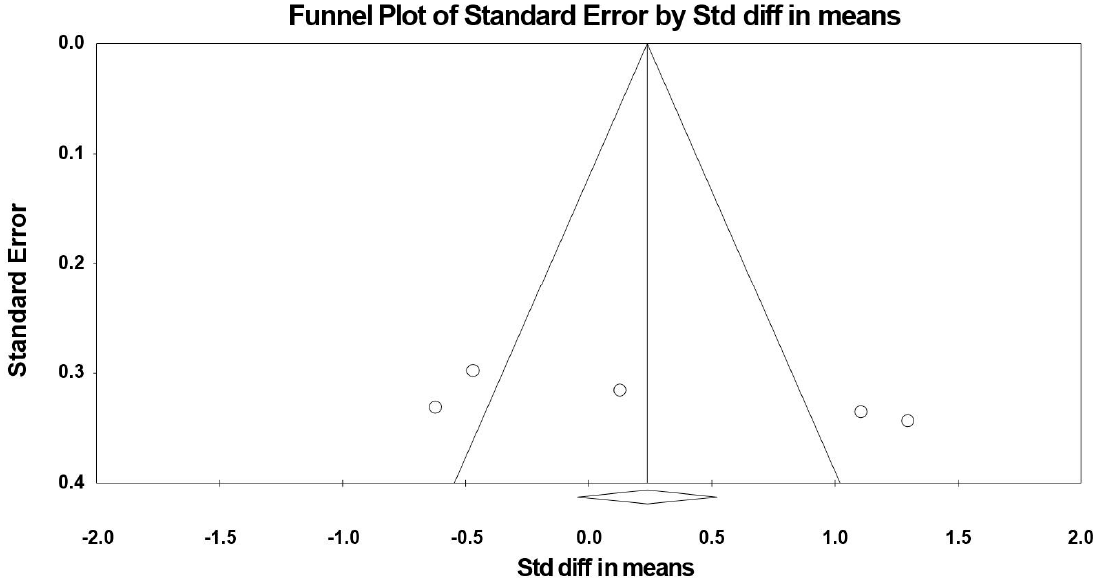
Figure 5. Funnel plot for RVIP showing no evidence of publication bias.